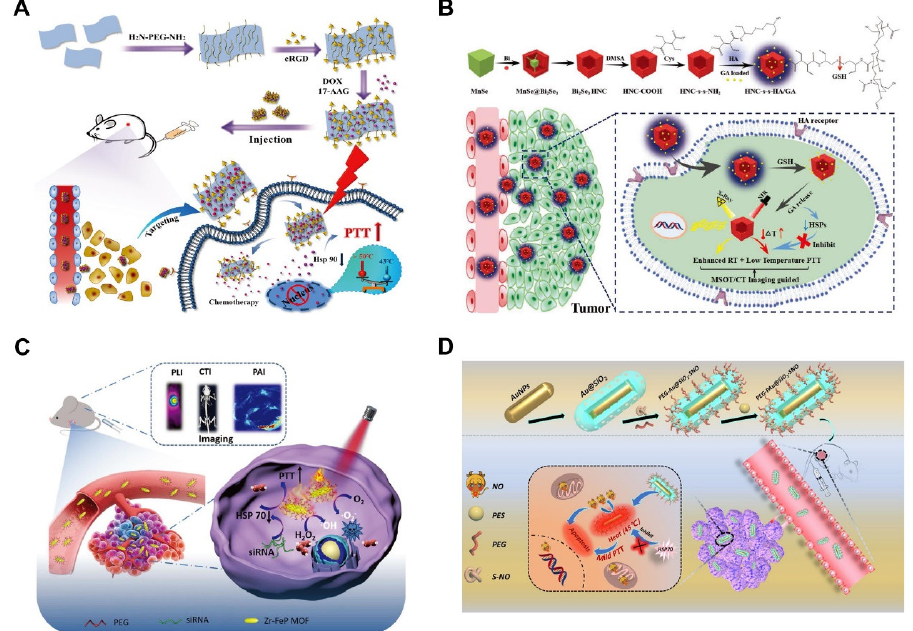
Figure 8. A variety of examples reveal the superiority of the synergistic therapy MTPTT with other therapies. ( A ) A schematic illustration of the preparation of DOX-17AAG@B-PEG-cRGD nanosheets and the synthetic approach of MTPTT with chemotherapy [81]. Copyright © 2022, Royal Society of Chemistry. ( B ) Illustration of synthesis procedure of HNC-s-s-HA/GA and the combination of MTPTT with radiotherapy [104]. Copyright © 2022, John Wiley and Sons. ( C ) Schematic illustration of siRNA/Zr-FeP MOF nanoshuttles for multimode imaging diagnosis and combination of MTPTT and PDT for cancer treatment [116]. Copyright © 2022, John Wiley and Sons. ( D ) Schematic illustration of the preparation of PEG-PAu@SiO 2 -SNO nanocomposites and the process of mild heat-enhanced gas therapy under NIR irradiation in MCF-7 cells [80]. Copyright © 2022, American Chemistry